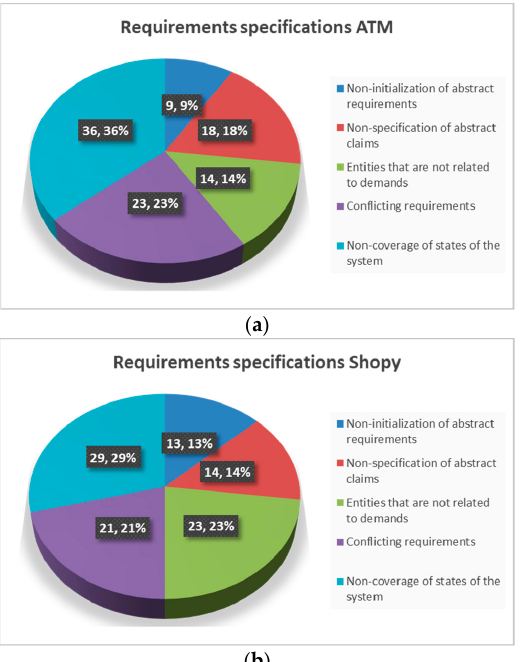
Figure 8. ( a ) Percentage analysis of the sub-cases in requirements specification for ATM use case; ( b ) percentage analysis of the sub-cases in requirements specification for Shopy use case.